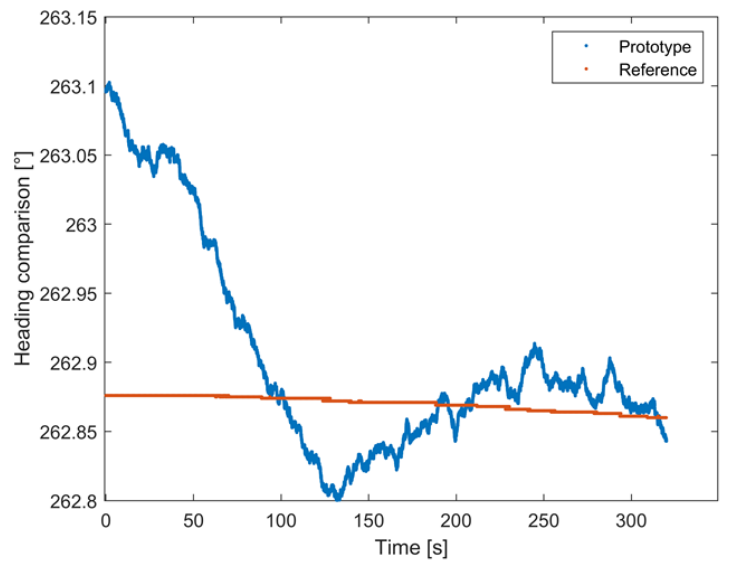
Figure 11. Heading angle comparison between the proposed system (blue) and FOG (red).